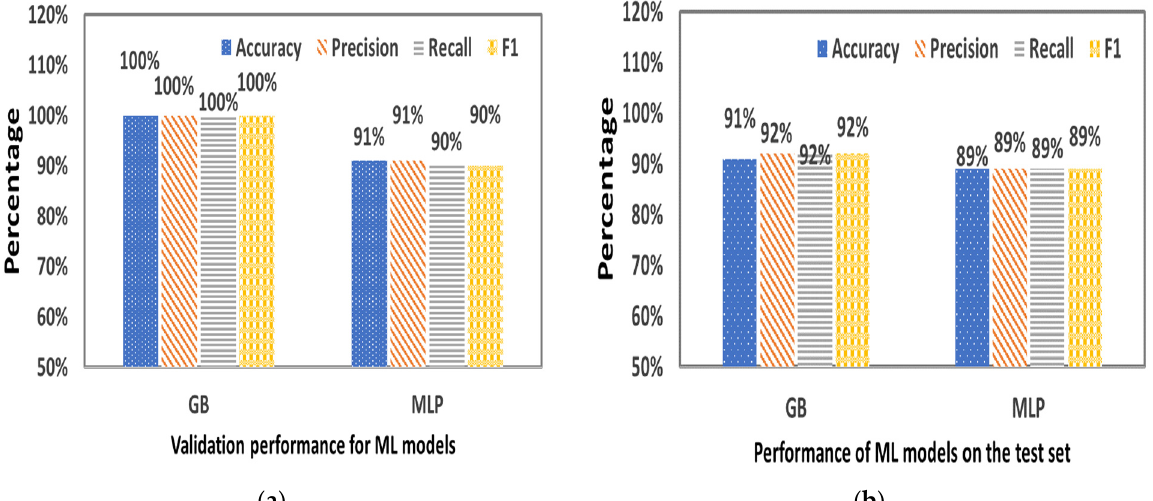
Figure 8. Statistical criteria resulted from ( a ) the validation (training sample 11,062) and ( b ) the performance (testing sample 2765) of GB and MLP algorithm in the RUN 1.